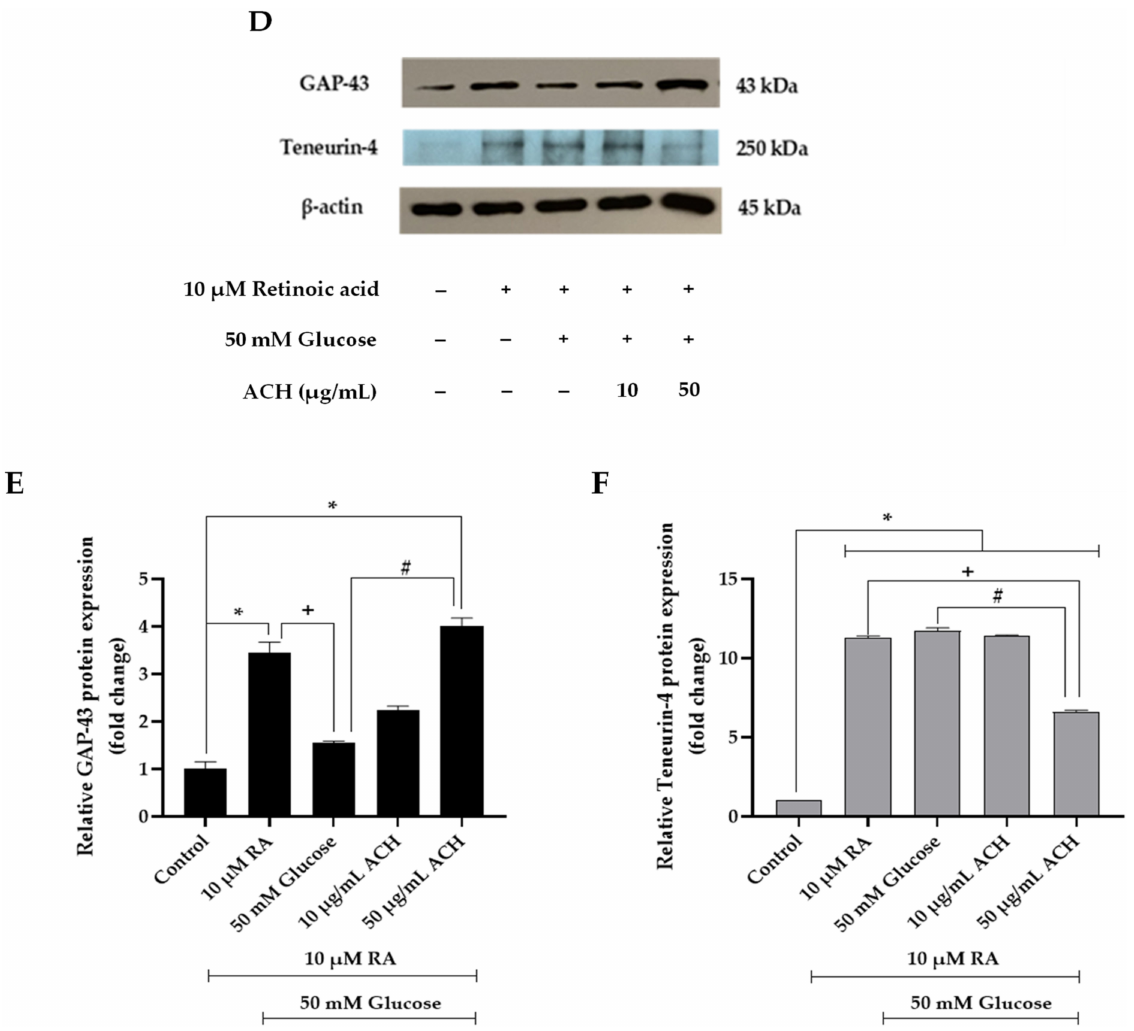
Figure 2. The neuroprotective effect of ACH on neuronal differentiation. The neurite outgrowth process was observed under a differential interference contrast (DIC) microscope at 10 × magnification (black lines represented the measurement of neurite outgrowth) ( A ). The number of bearing cells and neurite length are shown in ( B , C ), respectively. GAP-43 and Teneurin-4 expression is shown in a representative Western blot ( D ). Normalized values of both GAP-43 and Teneurin-4 against β -actin ( E , F ). All data are presented as the mean ± SEM, * p < 0.05 vs. control; + p < 0.05 vs. 10 µ M RA; # p < 0.05 vs. 50 mM glucose; ns = not